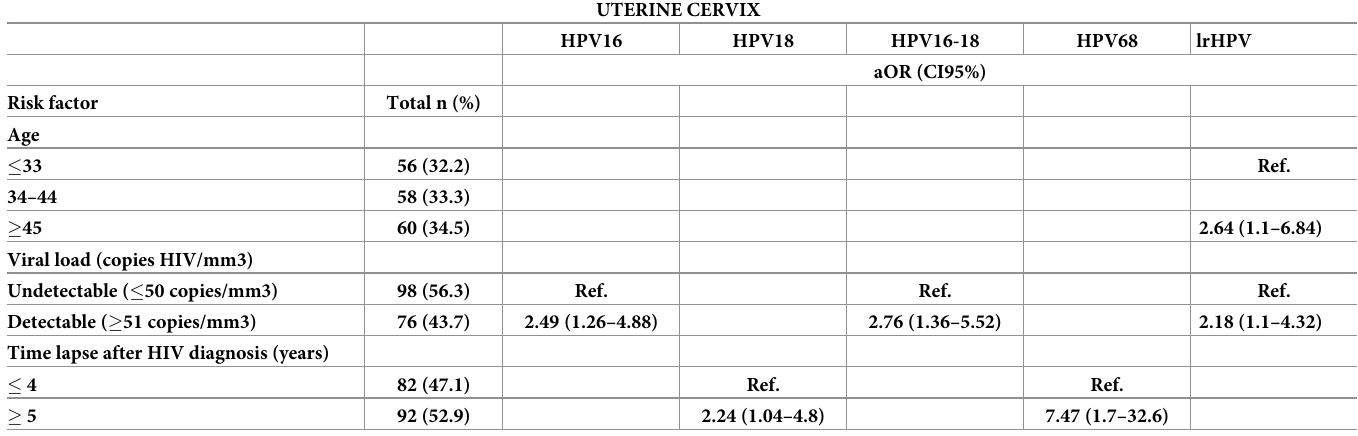
Table 3. Risk of hrHPV infections in the uterine cervix associated with sociodemographic and clinical factors (OR = adjusted odds ratio calculated by binary logistic regression; CI 95% = confidence interval at 95%).